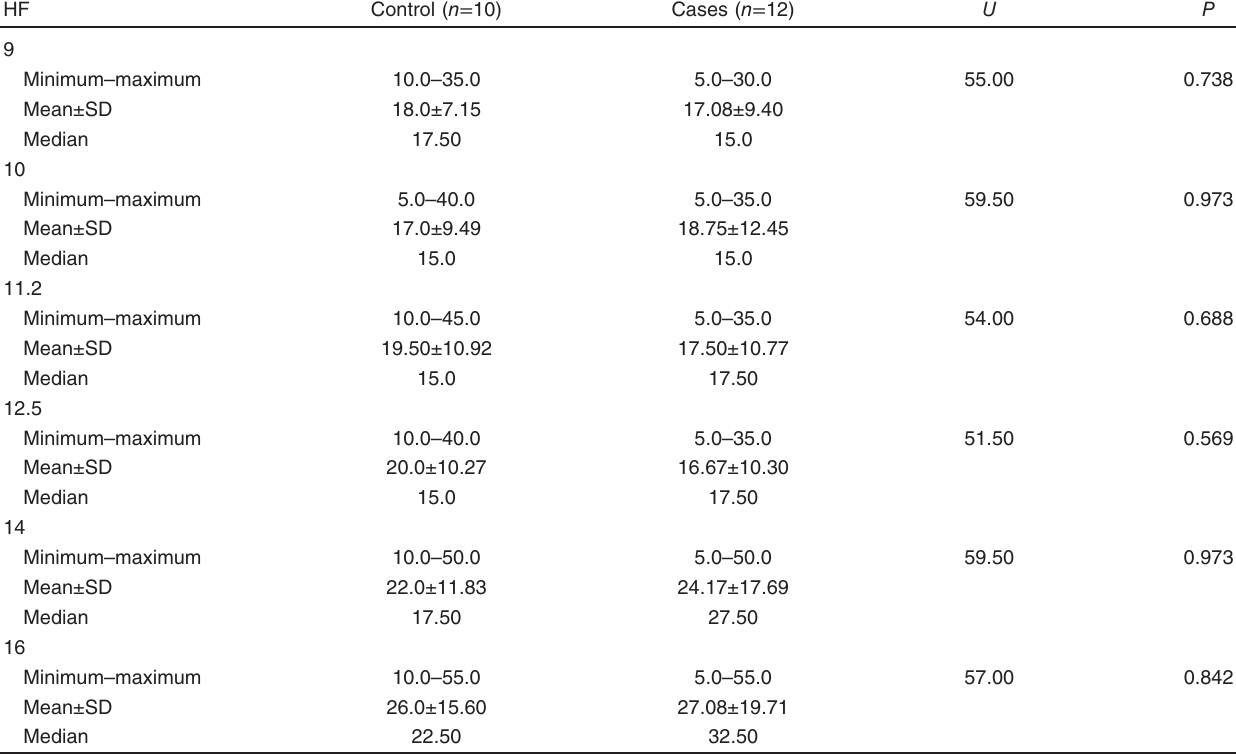
Table 4 High frequency audiometry thresholds in the two studied groups at age from 20 to 30